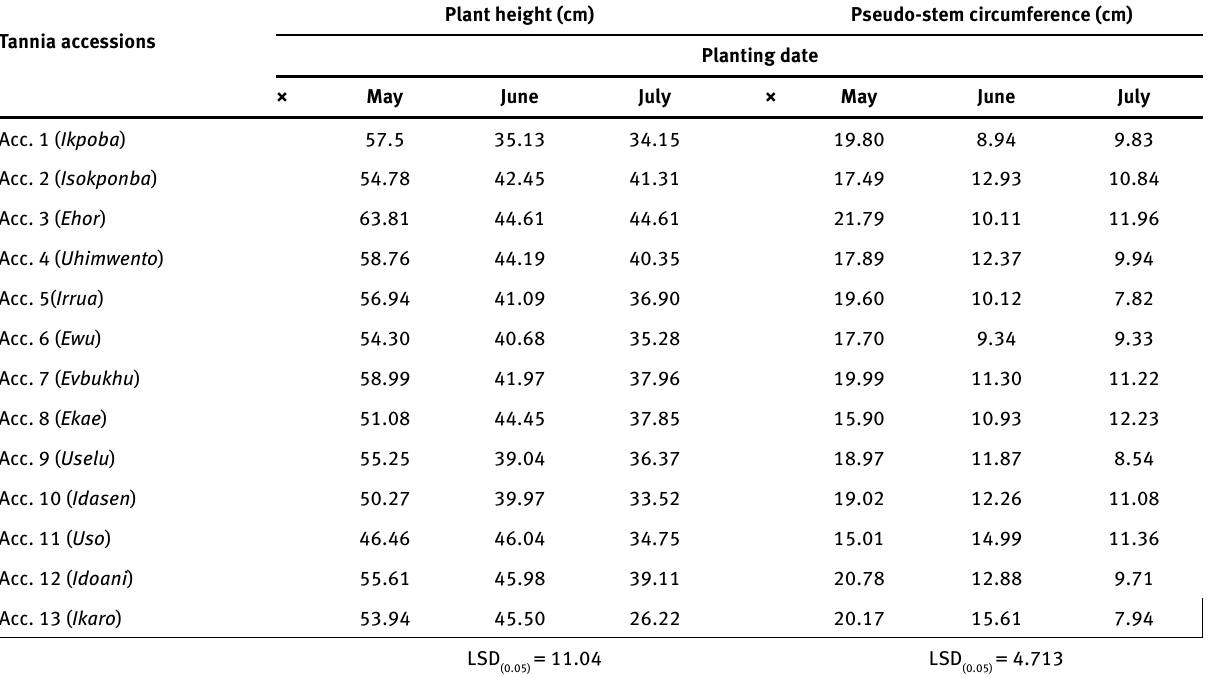
Table 5: Effect of interaction between planting date and tannia accessions on plant height and pseudo-stem circumference of corm in 2014 cropping season